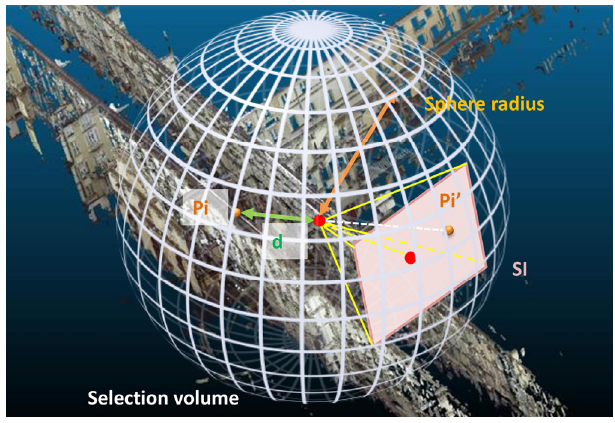
Figure 4. The selection sphere for RGB-D image generation.